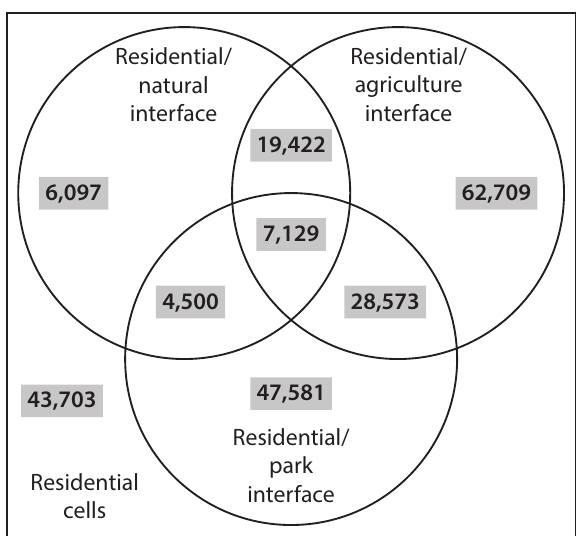
Figure 4. The universe of the residential cells considered in this study, distributed according to their location respective to green areas. Note: The word “interface” means “located within a buffer of 300 m.”